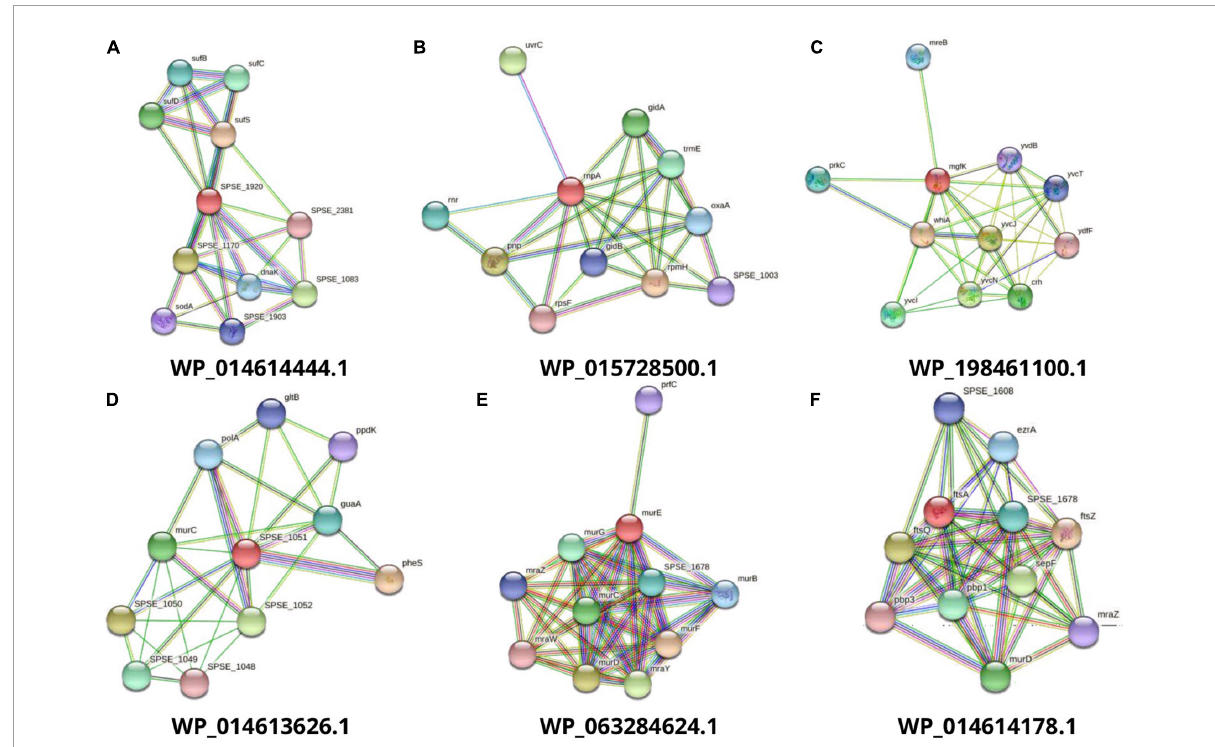
FIGURE2 Interaction analysis of predicted drug targets with other proteins using STRING database where query proteins are indicated by red color. The proteins with the best predicted three-dimensional structures (A to F) are shown to summarize the drug target’s PPI